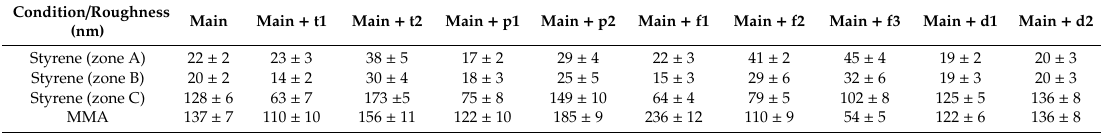
Surface roughness of styrene and MMA deposited thin films under di ff erent experimental